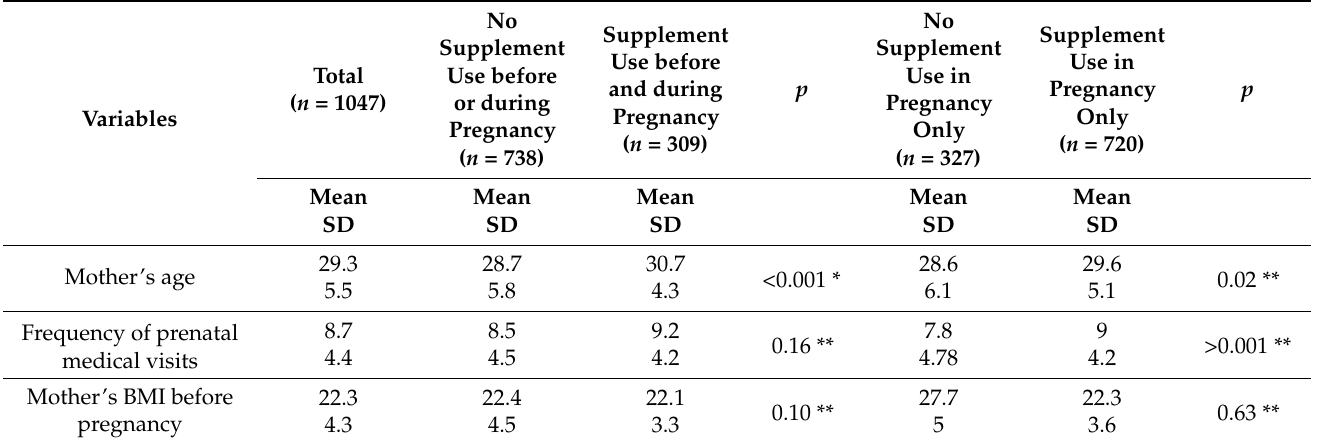
Table 2. Basic characteristics of women interviewed about vitamin supplement use before and during pregnancy, Tirgu Mures, Romania, 2015–2016.